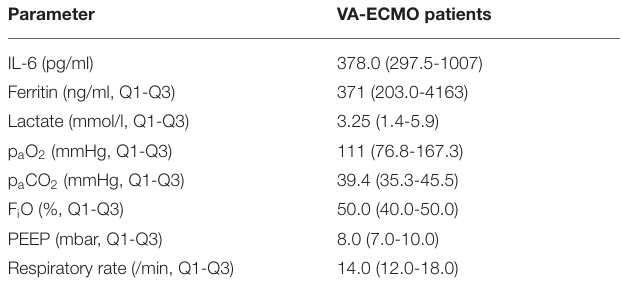
TABLE 1 | Clinical characteristics, laboratory parameters, and ventilation settings of VA-ECMO patients on day 0. Parameter